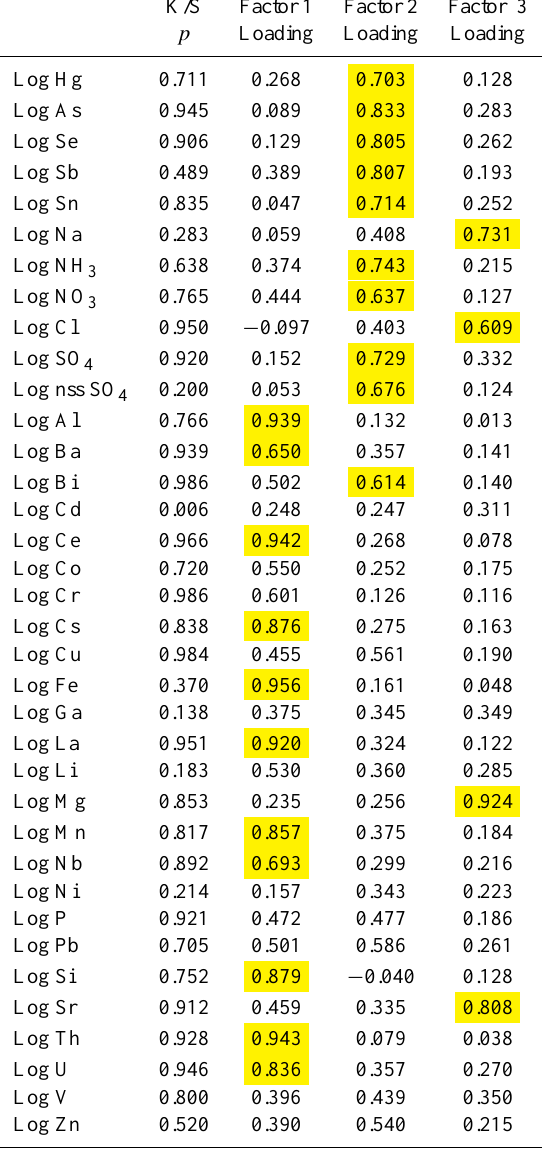
Table 2. Varimax rotated factor matrix of the log-transformed rain- fall flux data using SPSS Statistics 17.0. The Kolmogorov-Smirnov statistic with Lilliefors’ Significance was used to test for normality in the log-transformed flux data. None of the data distributions, ex- cept Cd ( p =0.006), were significantly different from normal distri- butions. Factor loadings are equivalent to R correlation coefficients. R values greater than 0.6 are highlighted.